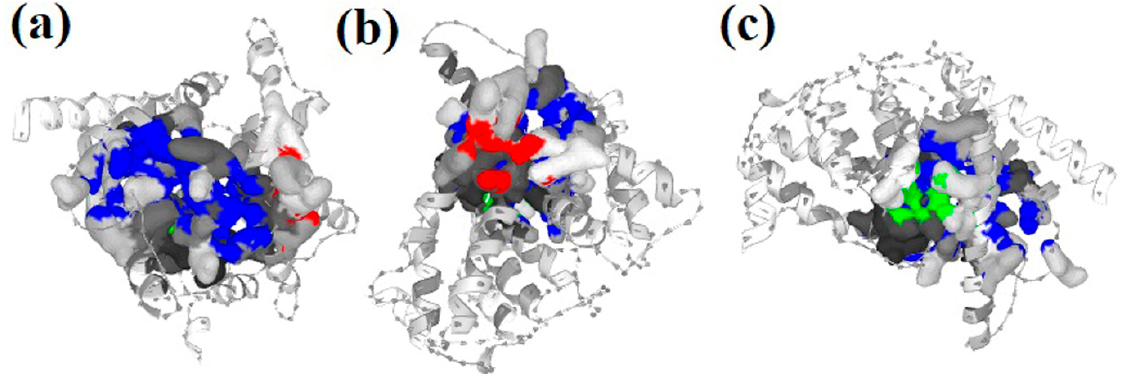
Figure 2. The PrankWeb tool is used to predict the binding pockets and correspondence binding sites of the PDE5 enzyme. Three binding pockets were predicted with different colors. The first pocket is colored in blue with a pocket score of 67.90, 36 amino acids, and a probability score of 0.990 ( a ). The second pocket is in red, with a pocket score of 1.23, 7 amino acids, and a probability score of 0.012 ( b ). The third pocket is in green with a pocket score of 1.15, 9 amino acids, and a probability score of 0.010 ( c ).